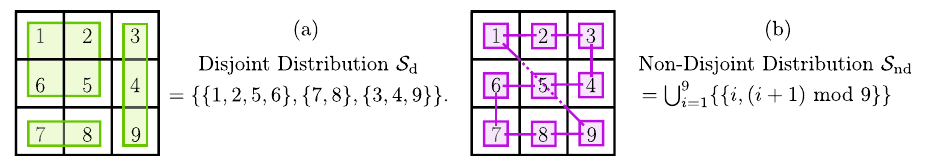
Fig. 3 Diagrammatic protocol representation. a Disjoint and b non-disjoint distributions of multipartite probe domains. The example in b is in fact the nearest-neighbour con fi guration described in Eq.